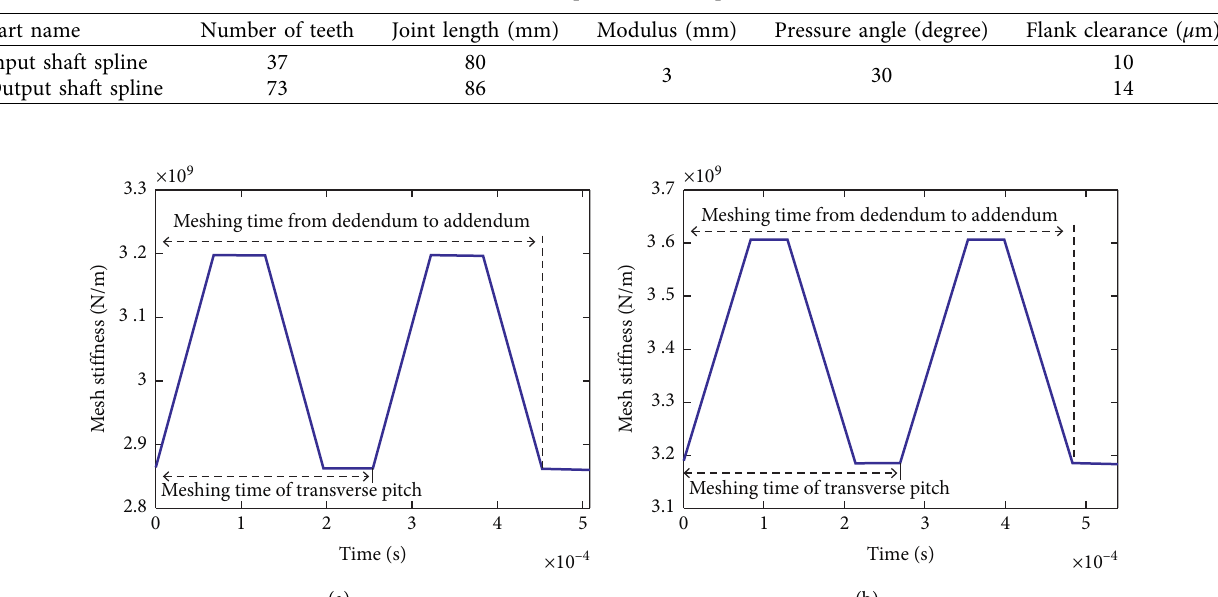
Table 2: Basic parameters of